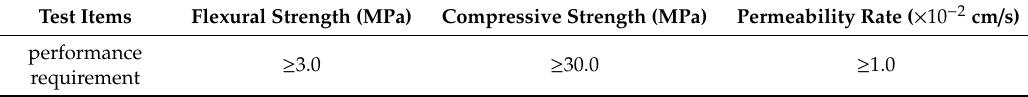
Table 1. Performance parameters of permeable bricks specified in national standard GB / T 25993-2010